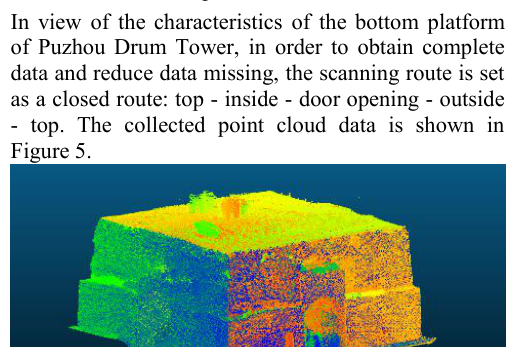
Table 2 Main Specifications of Geo SLAM